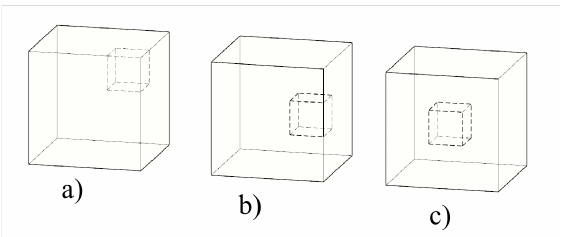
Figure 2. Solid/Solid cover at face: B is covered by A and a) has a common vertex and edges; b) has a common edge; c) and has a common